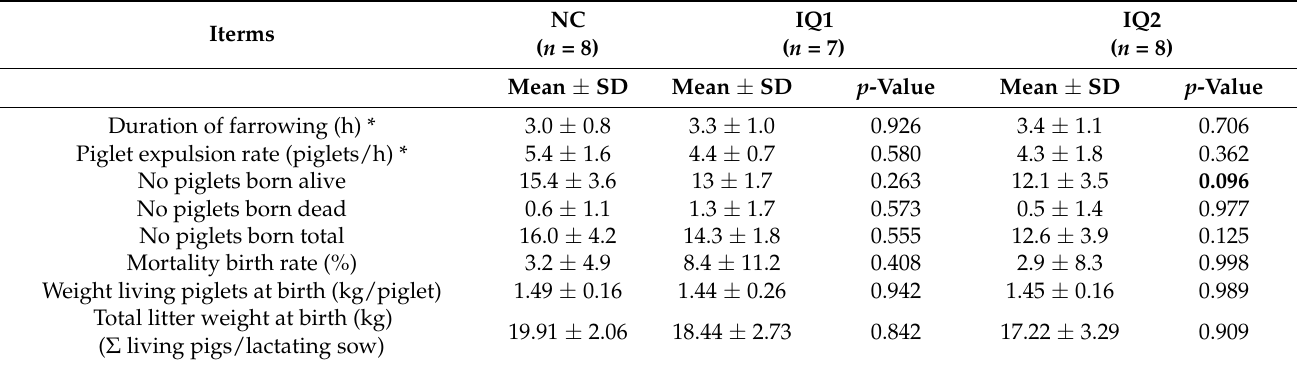
Table 4. Sows’ performance at farrowing during the experiment. Sows received either a basal diet (NC), or supplementation with isoquinoline alkaloids (IQ) during gestation and lactation (IQ1), or only during the lactation period